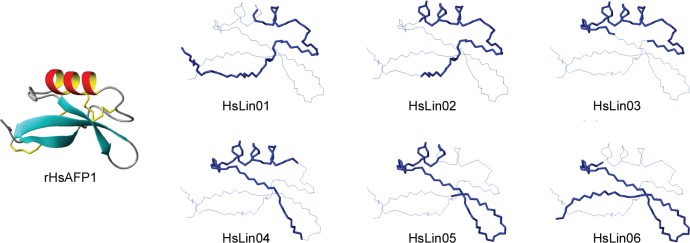
Representation of the HsLin peptides imposed on the rHsAFP1 structure, according to the amino acid sequence.HsLin peptides are shown as a thick blue line in the same orientation as rHsAFP1; other residues of rHsAFP1, not present in the HsLin peptide, are shown as a thin blue line. Note that (i) the cysteine residues are replaced by α-aminobutyric acid to avoid formation of disulfide bonds and that (ii) the CSαβ scaffold is not present in the HsLin peptides, and therefore, the peptides do not adopt the same conformation as the mature rHsAFP1.